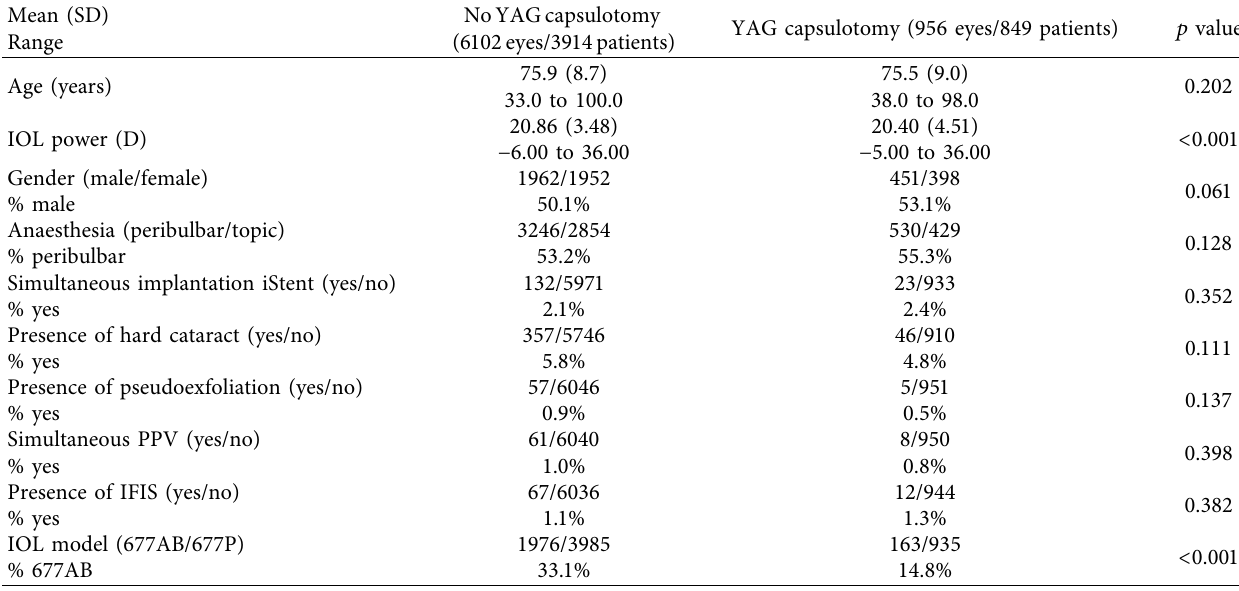
Table 1: Differences between eyes requiring YAG capsulotomy and those not needing it in different preoperative and intraoperative variables.